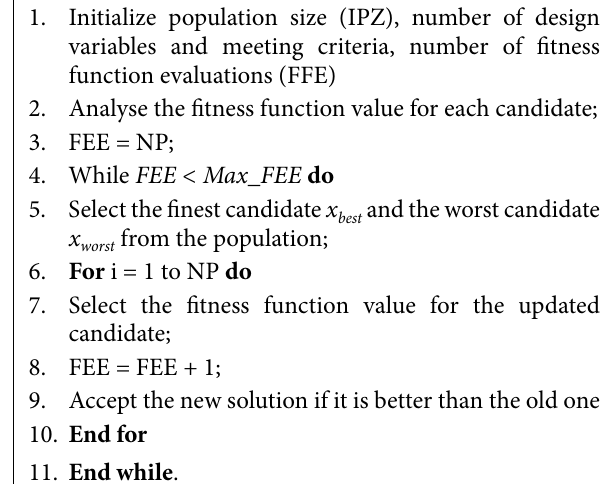
Algorithm 1: The pseudocode of JAYA